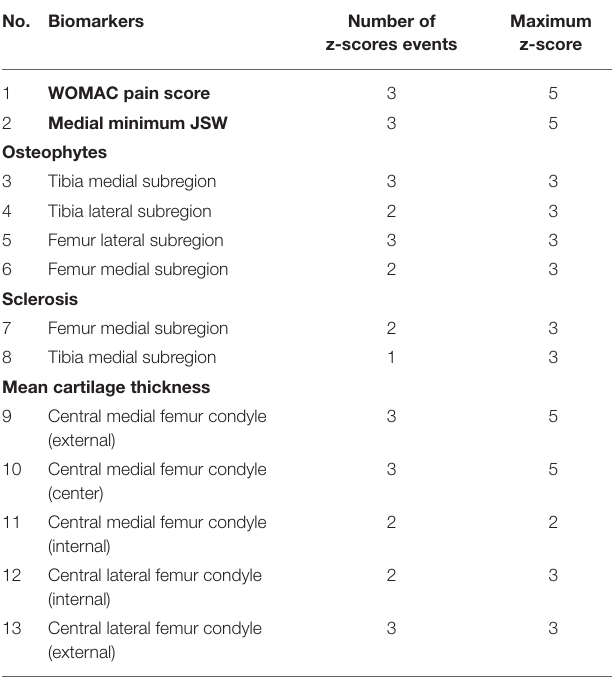
The order numbers of biomarker in Table 1 match the numbers in Figure 2A